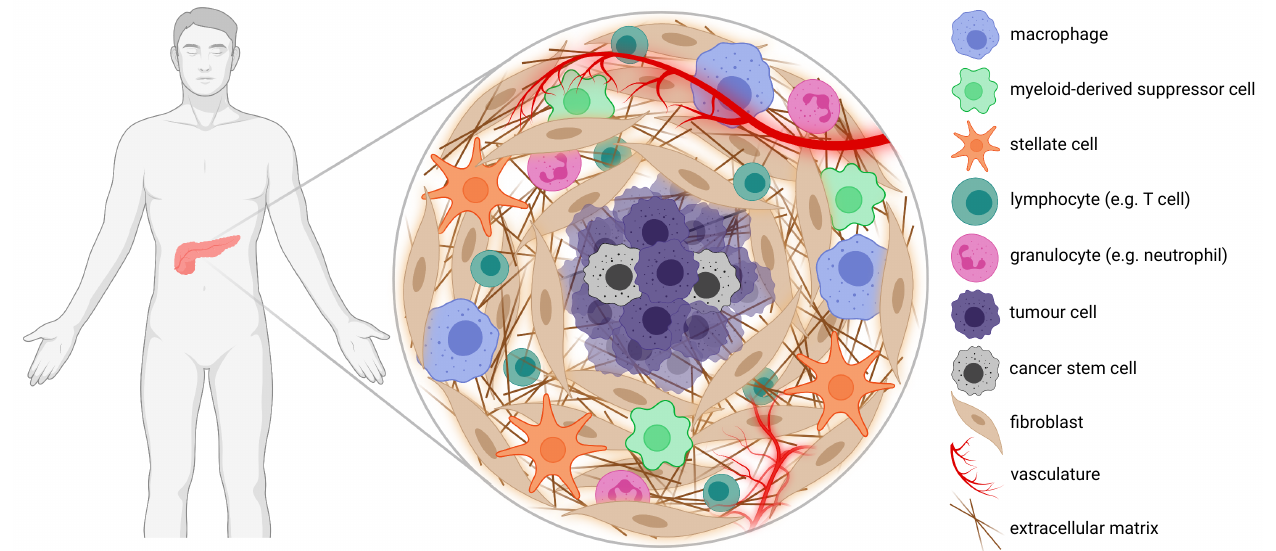
Figure 2. Cellular and acellular elements of PaCa stroma with established roles in treatment resistance. PaCa is characterised by an abundant desmoplastic stroma populated by non-malignant cells such as macrophages, fibroblasts and regulatory T cells. The biological actions and interplay of these cells create a nurturing environment for tumour growth that can markedly limit the effectiveness of therapy. Response to treatment is further impaired by a lack of functional vasculature and fibrotic deposits of ECM throughout the stroma, which pose physical barriers to drug delivery. Collectively, these features highlight the significance of the stroma as a rich source of actionable targets for overcoming PaCa